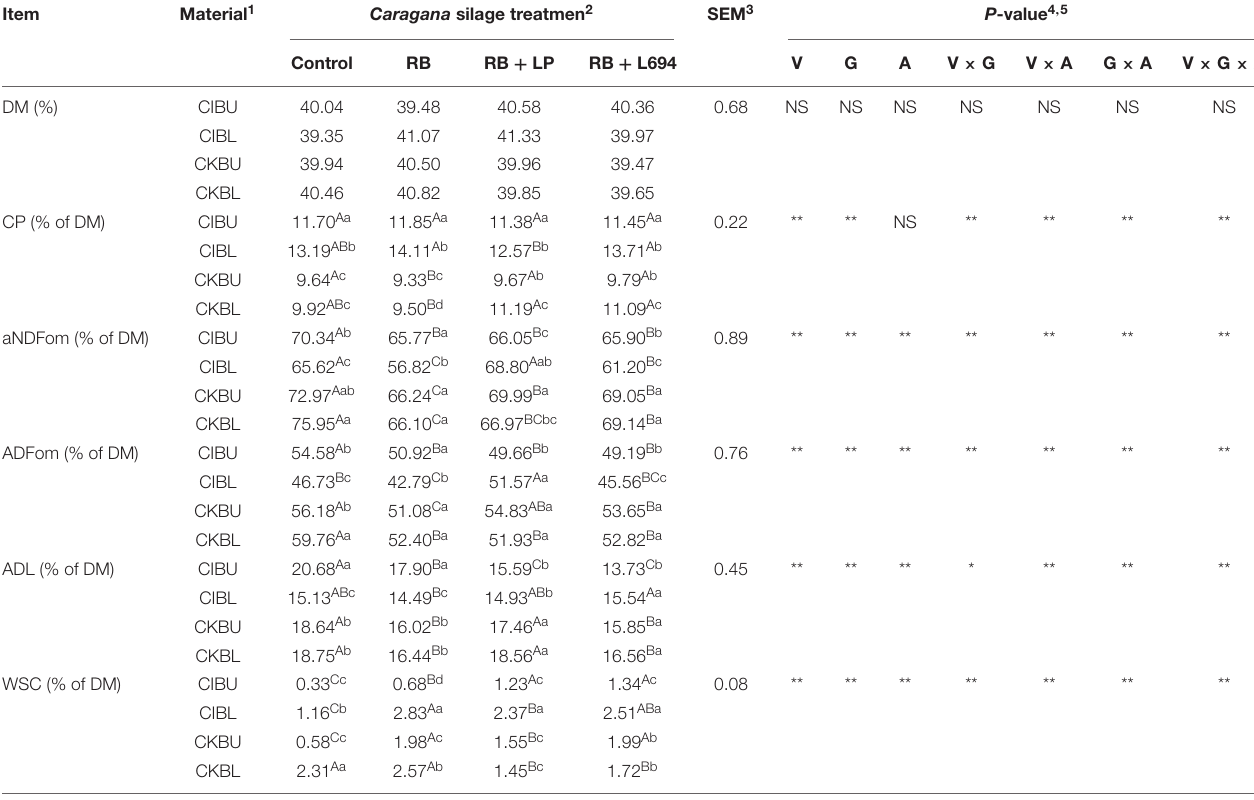
TABLE 4 | Chemical composition of Caragana silages prepared without and with RB and LAB at different growth stages ( n = 3). Item Material 1 Caragana silage treatmen 2 SEM 3 P -value 4 , 5